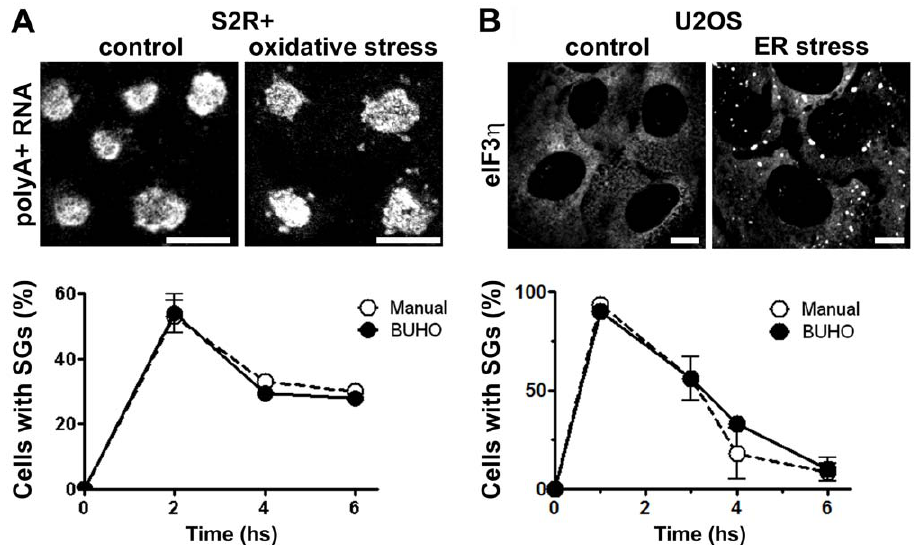
Figure 2. Time course of SG formation. A, Drosophila S2R + cells were exposed to oxidative stress and SGs were visualized by FISH. B, ER-stress was induced in U2OS cells and SGs were visualized by immunofluorescence of eIF3 g . Confocal images (63 6 , 1024 6 1024 pixels) were analyzed manually or with BUHO with a scaling down to 512 6 512. Ten micrographs from triplicate wells (A) and 5 micrographs from duplicates (B) were analyzed at each time point. Error bars indicate standard deviation. Size bar, 10 m